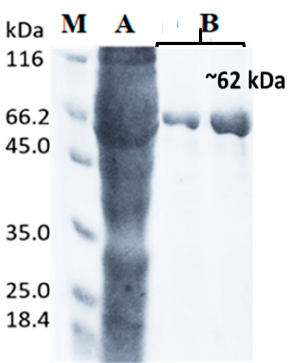
Figure 5. SDS-PAGE profile of recombinant LIP2 lipase. (M) Protein molecular weight marker (Thermo Fisher Scientific, Waltham, MA, USA) (A) Crude LIP2 lysate, (B) Eluted fraction contained purified LIP2 lipase. Table 1. Summary of the LIP2 purification procedure.